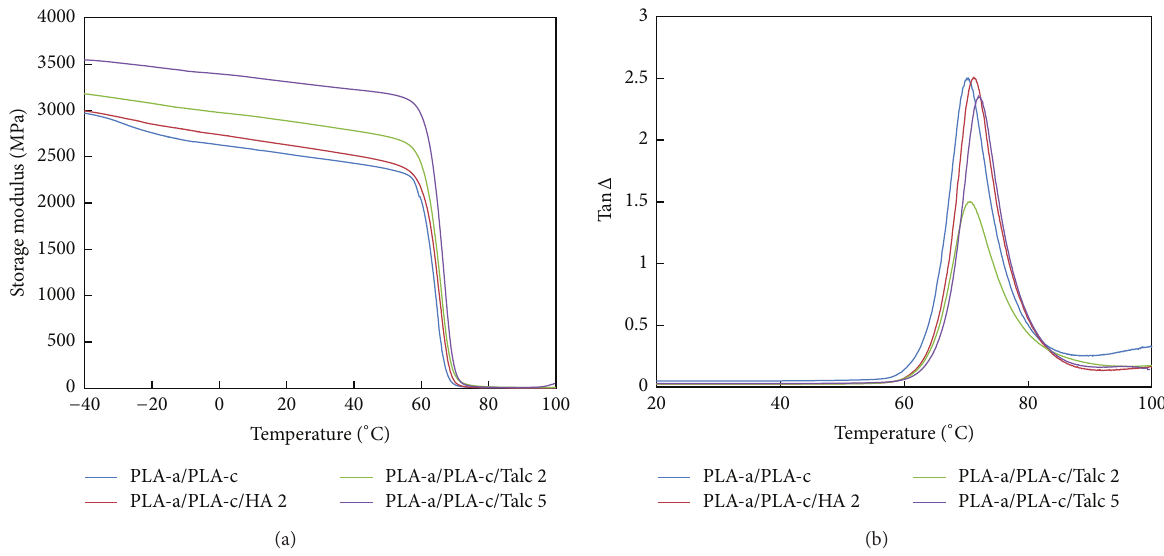
Figure 6: Effect of the weight percent of the filler on the storage modulus and Tan Delta of the blends of crystalline PLA and amorphous PLA